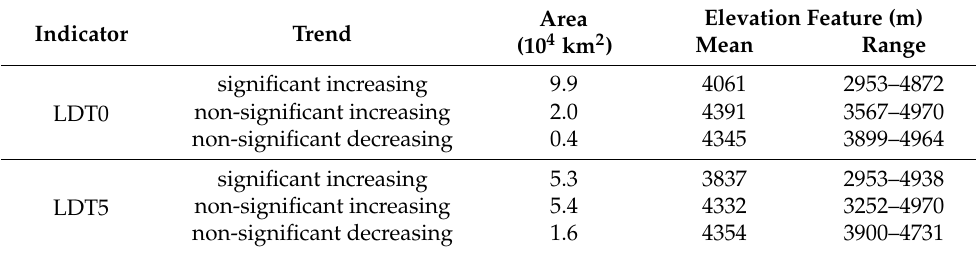
Table 7. The area and elevation features of trends in the